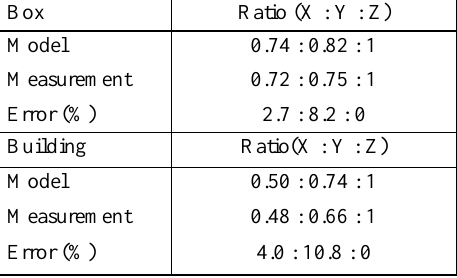
Table 2. Errors in length